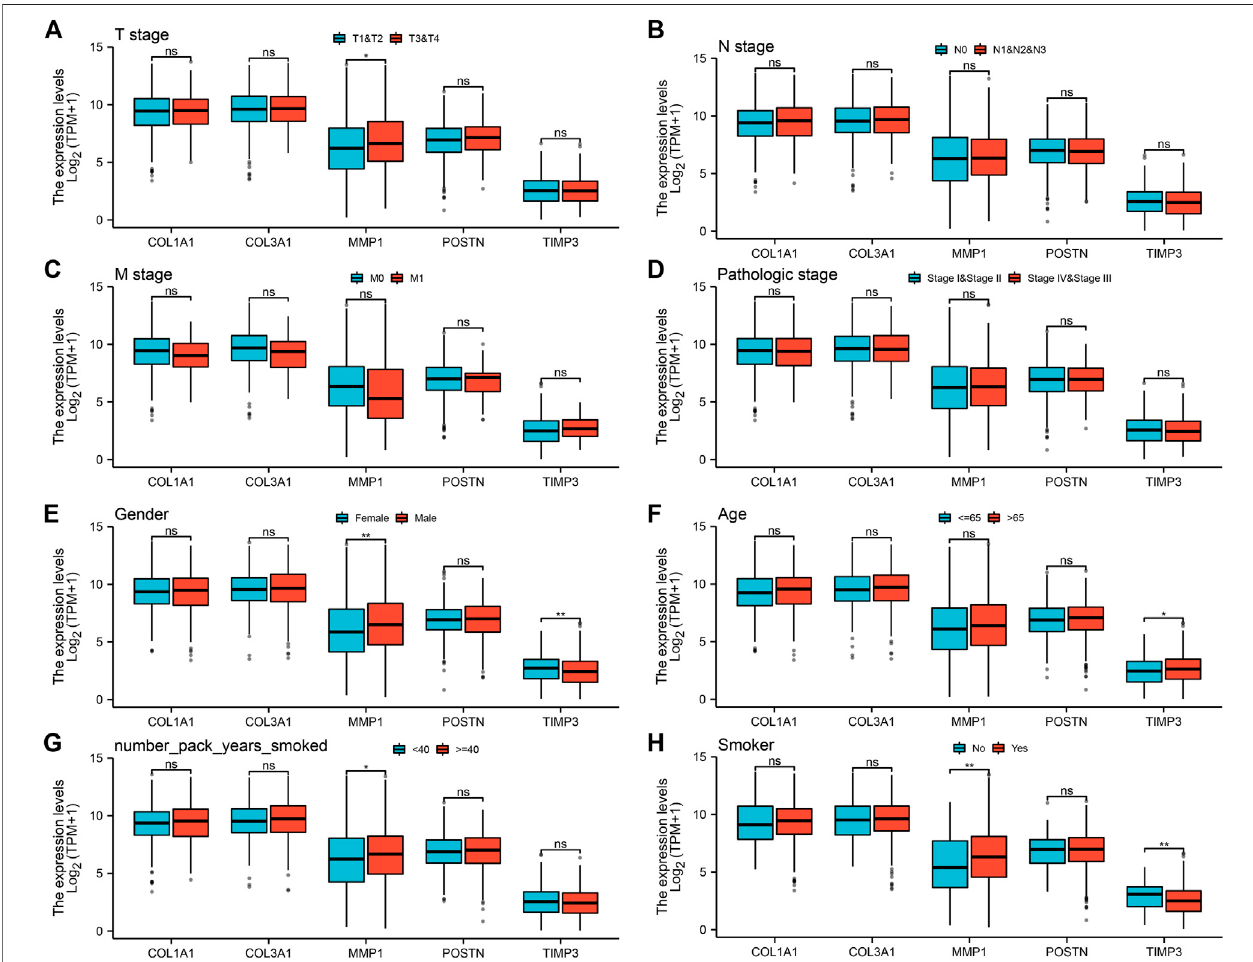
FIGURE5 | Analysisoftheassociationbetweenthe fi vehubgenesandclinicopathologicalfeaturesofNSCLCpatients.Notes: (A) :Theexpressionlevelof fi vehubgenesin NSCLCpatientswithdifferentTstage(T1-2vsT3-4;T1-2:872individuals,T3-4:162individuals),ns= p > 0.05,*= p < 0.05,**= p < 0.01,***= p < 0.001; (B) :Theexpressionlevel of fi vehubgenesinNSCLCpatientswithdifferentNstage(N0vsN1-3;N0:668individuals,N1-3:347individuals),ns= p > 0.05,*= p < 0.05,**= p < 0.01,***= p < 0.001; (C) :The expressionlevelof fi vehubgenesinNSCLCpatientswithdifferentMstage(M0vsM1;M0:773individuals,M1:32individuals),ns= p > 0.05,*= p < 0.05,**= p < 0.01,***= p < 0.001; (D) :Theexpressionlevelof fi vehubgenesinNSCLCpatientswithdifferentclinicalstage(StageI-IIvsStageIII-IV;StageI-II:824individuals,StageIII-IV:201individuals), ns = p > 0.05, * = p < 0.05, ** = p < 0.01, *** = p < 0.001; (E) : The expression level of fi ve hub genes in NSCLC patients with different gender (Female vs Male; Female: 417 individuals,Male:620individuals),ns= p > 0.05,*= p < 0.05,**= p < 0.01,***= p < 0.001; (F) :Theexpressionlevelof fi vehubgenesinNSCLCpatientswithdifferentage( ≤ 65vs > 65; ≤ 65: 446 individuals, > 65: 563 individuals), ns = p > 0.05, * = p < 0.05, ** = p < 0.01, *** = p < 0.001; (G) : The expression level of fi ve hub genes in NSCLC patients